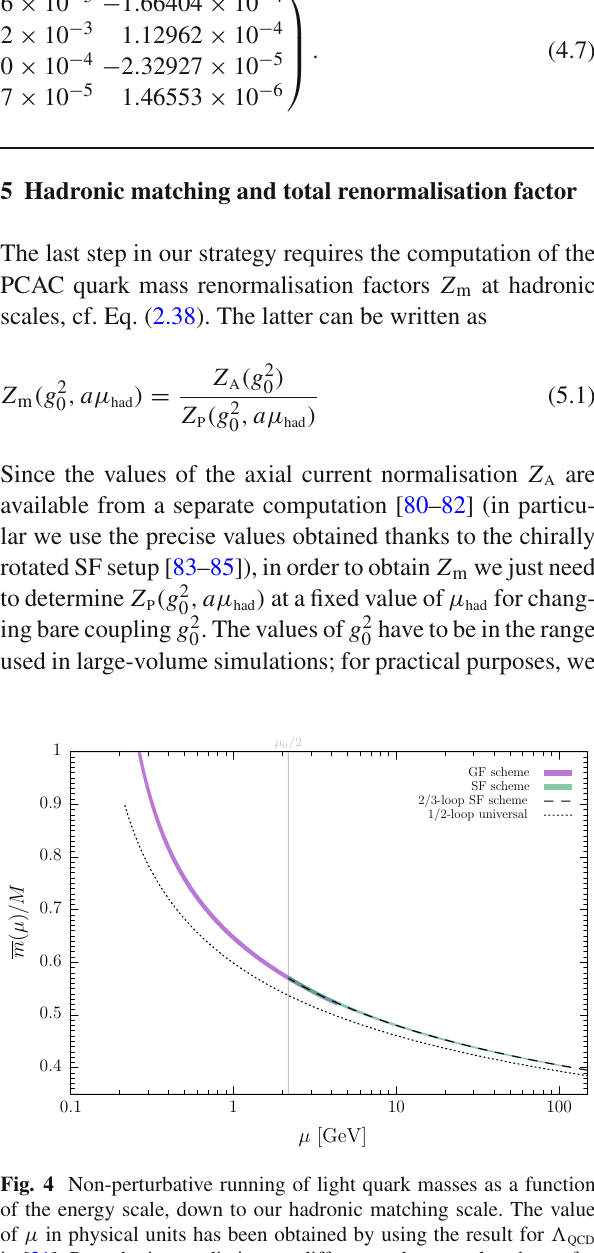
Fig. 3 Non-perturbative mass anomalous dimension in the SF (green) andGF(purple)regions.Perturbativepredictionsatthehighestavailable orders are also shown for comparison